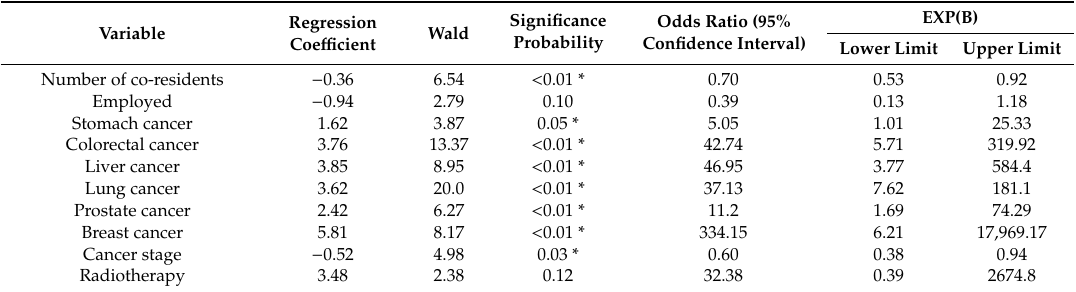
Table 4. Correlation between related factor(s) and High or Low FOIS by multivariate